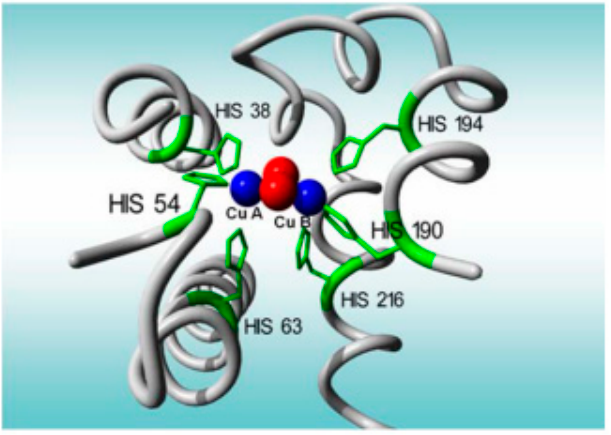
Figure 4. Active sites of the tyrosinase enzyme [73].